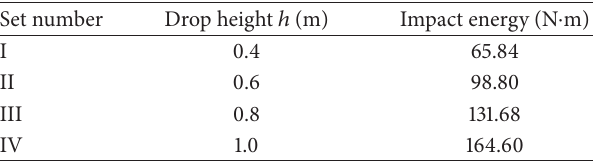
Table 3: Drop heights and impact